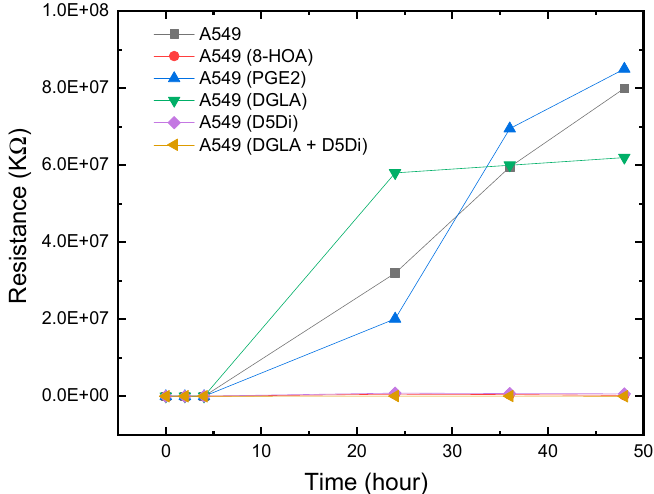
Figure 7. Resistance change measured using Ti 3 C 2 MXene-based sensors for A549 cancer cells with and without using the new anti-cancer treatment .